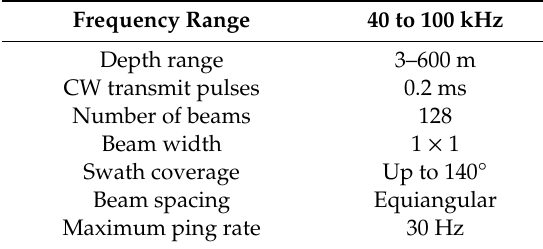
Table 1. Sonar settings of the EM